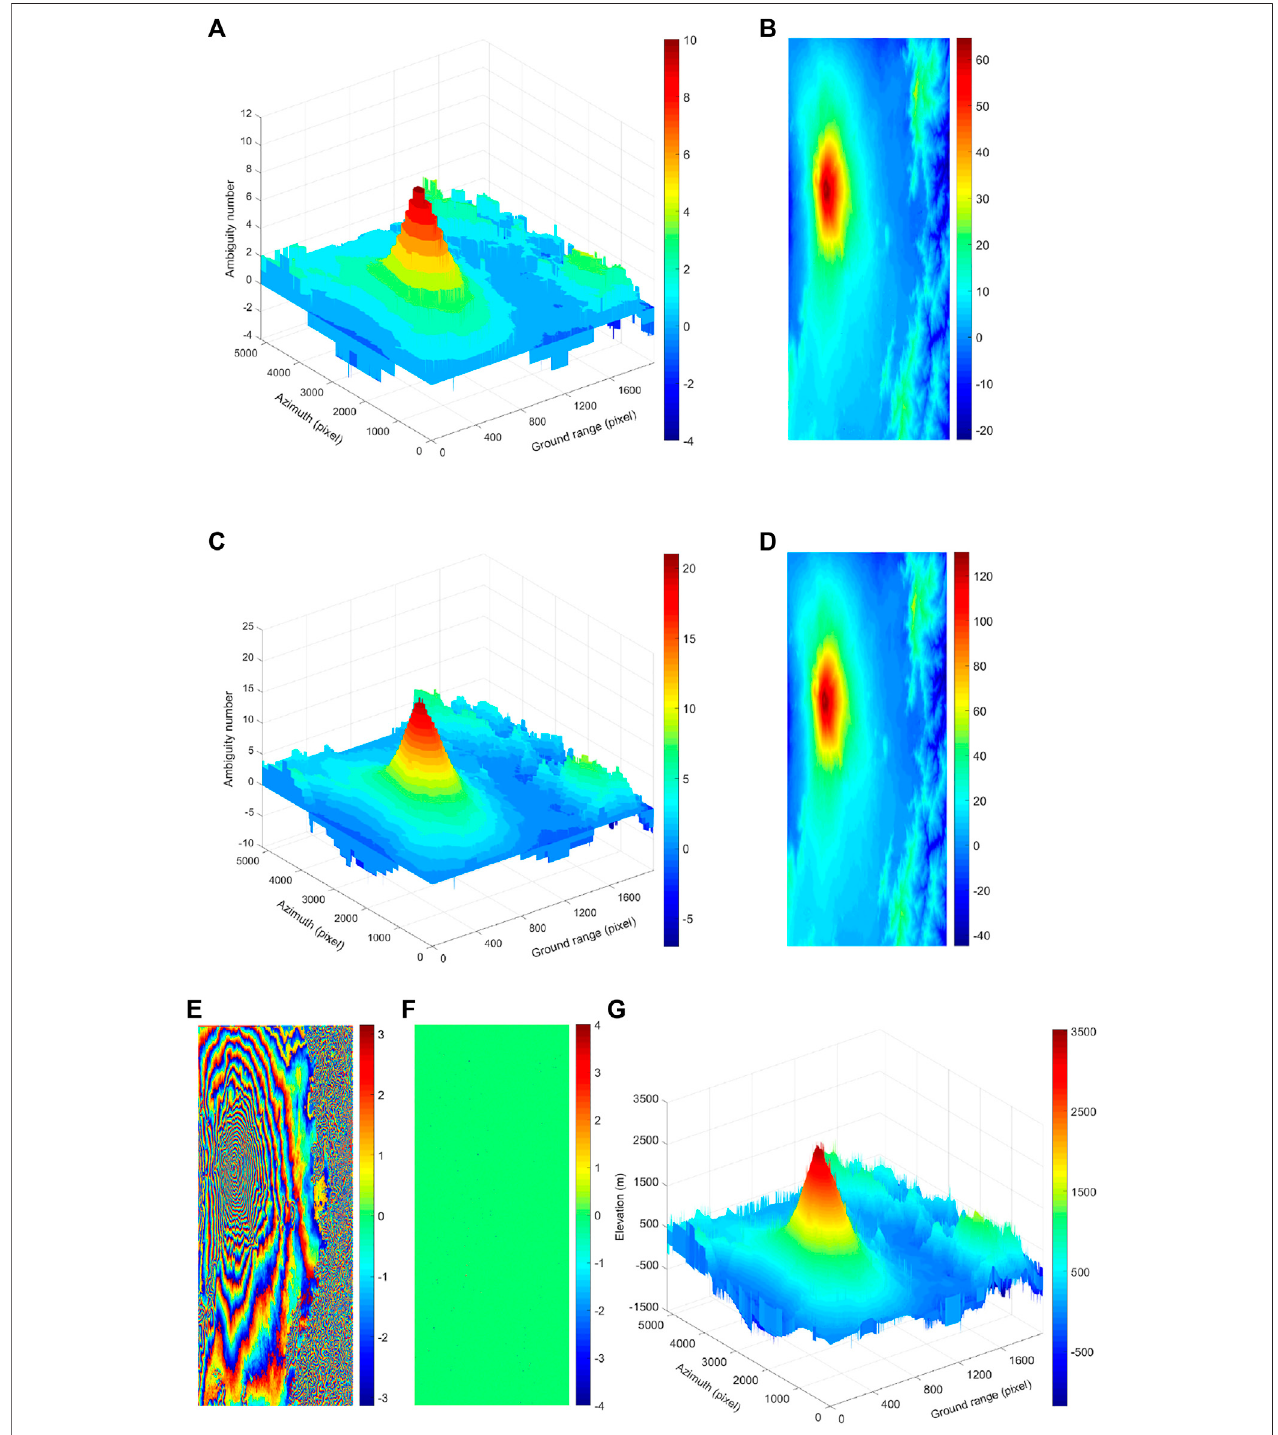
FIGURE 17 | Unwrapping results of real data. (A) 3D map of the solved ambiguity numbers for short-baseline interferogram. (B) Unwrapping results for short- baseline interferogram (rad). (C) 3D map of the solved ambiguity numbers for long-baseline interferogram. (D) Unwrapping results for long-baseline interferogram (rad). (E) Re-wrapped results of long-baseline (rad). (F) Phase errors between re-wrapped results and original interferogram (rad). (G) Inverted DEM (m).